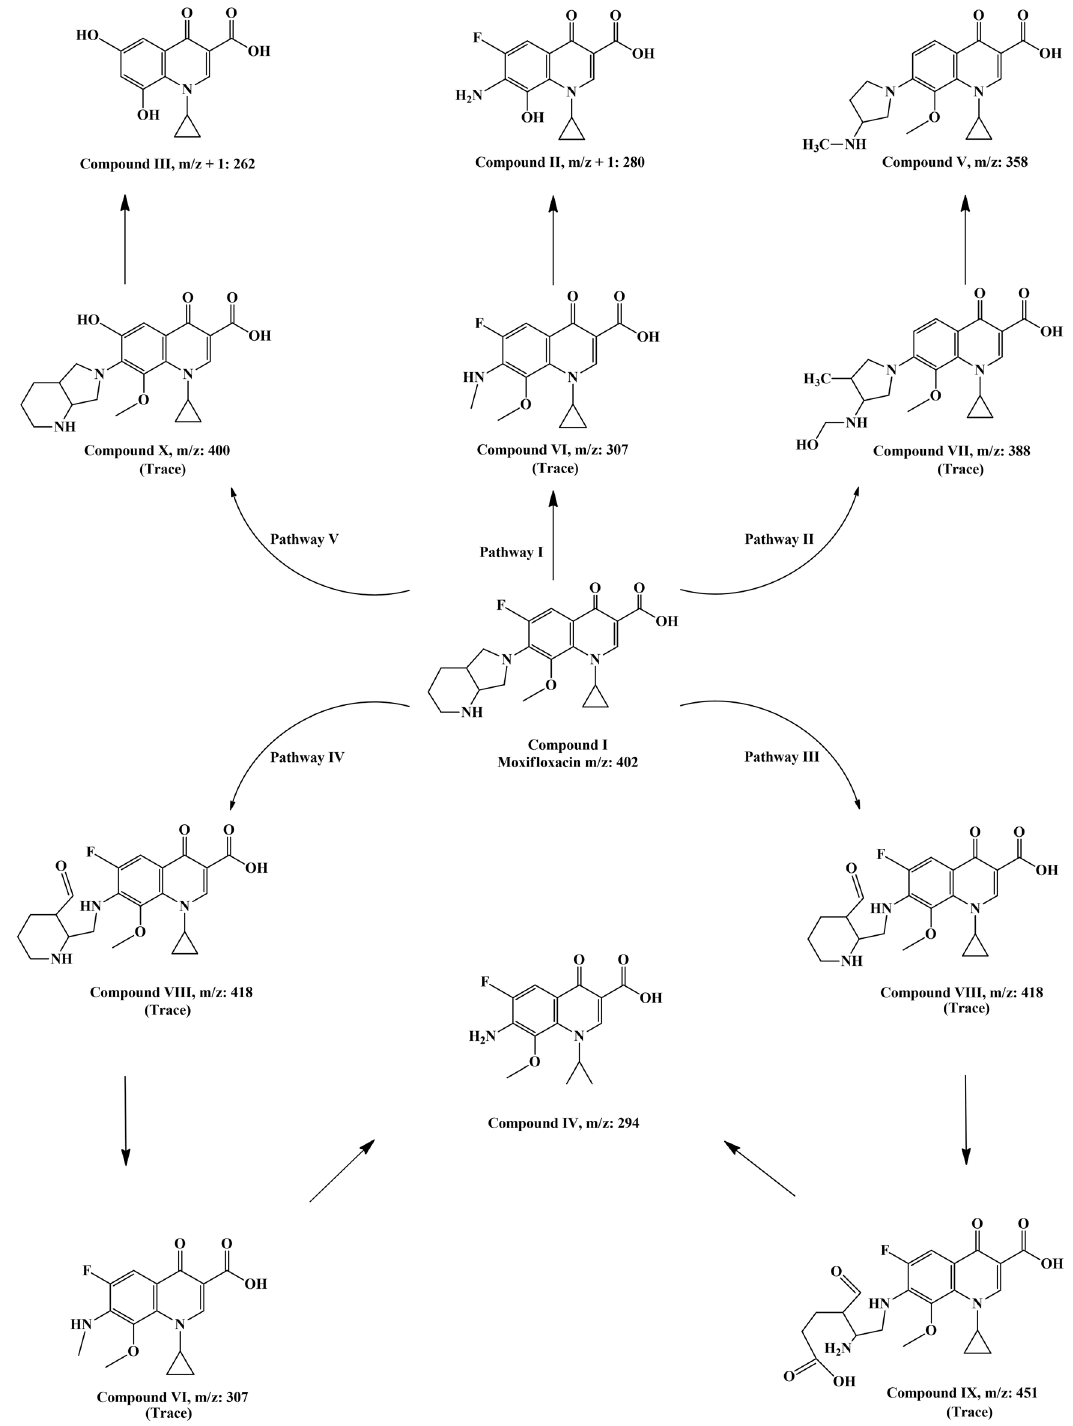
Figure 6. Mechanism of moxifloxacin degradation. Proposed moxifloxacin biotransformation pathways by